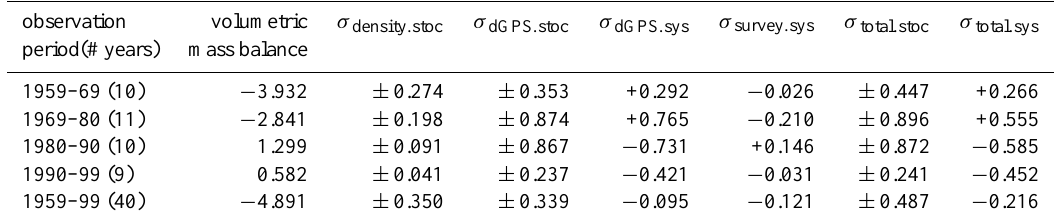
Table 3. Volumetric mass balances and related stochastic and systematic uncertainties with regard to density assumptions ( σ density ) , survey dates ( σ survey ) , and to the photogrammetric processing of the DEMs based on independent dGPS measurements ( σ dGPS ) . Overall uncer- tainties are calculated based on the law of error propagation for the stochastic estimates ( σ total . stoc ) and as sums for the systematic estimates ( σ total . sys ) . All values are cumulated over the corresponding observation period with units in meter water equivalent (m w.e.). Note that the observation periods refer to the years of the corresponding aerial